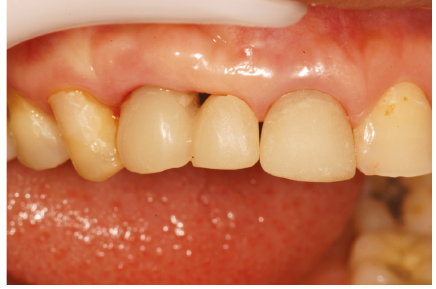
Figure 8: Presence of the black triangle before gingival conditioning.